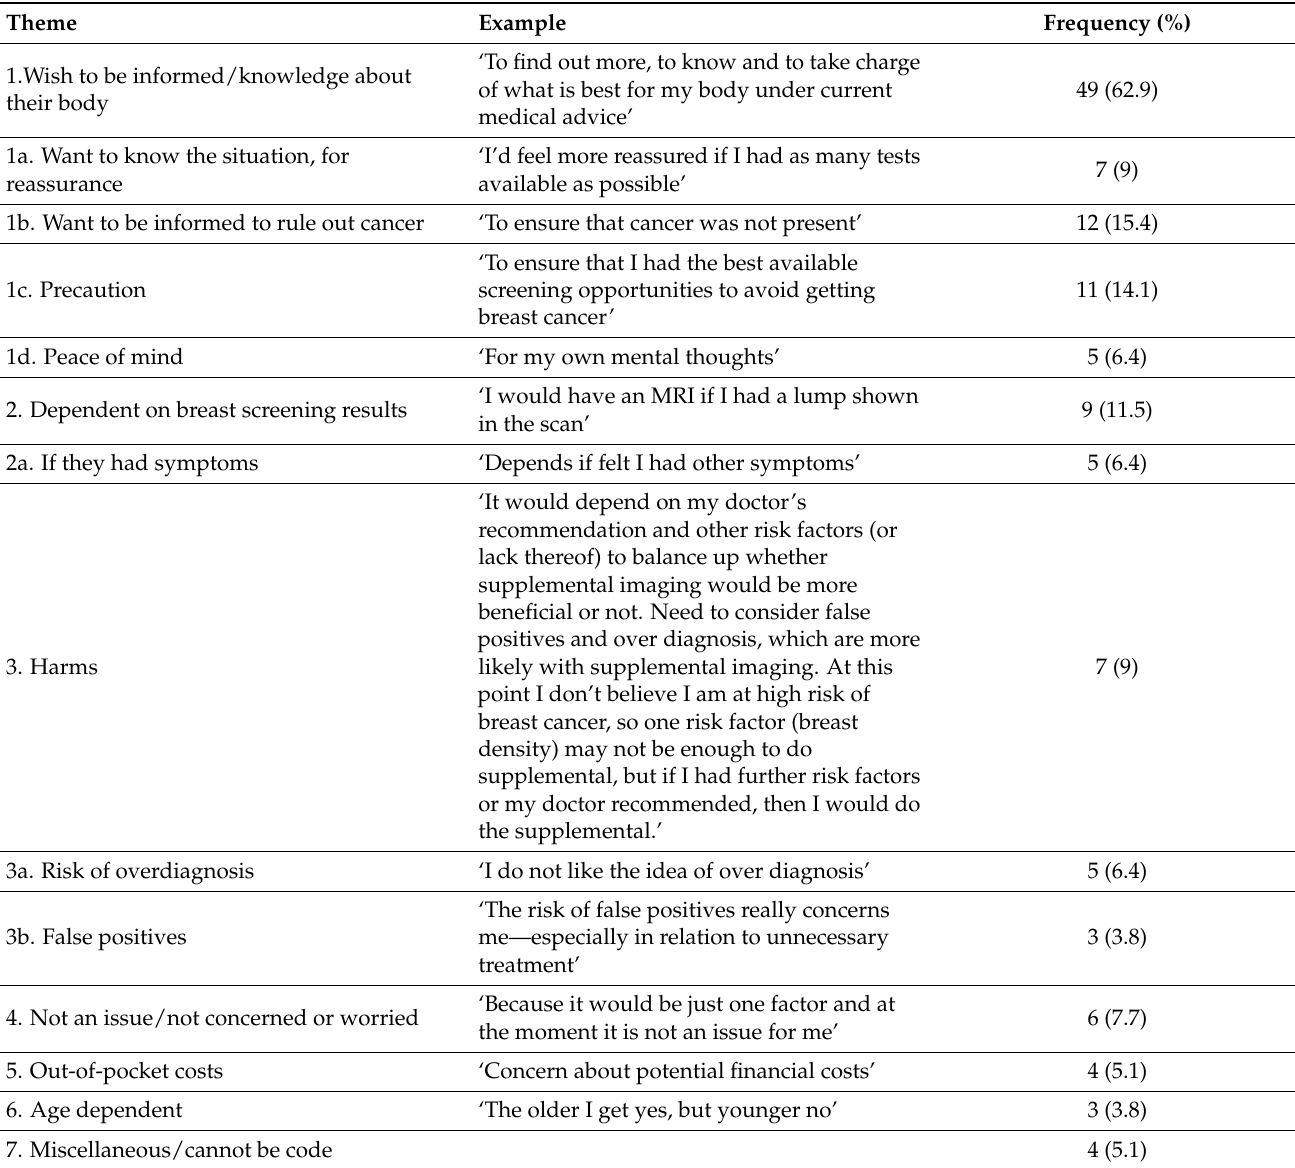
Table 4. Main themes and sub-themes for supplemental screening with quotations and frequencies ( n = 78)